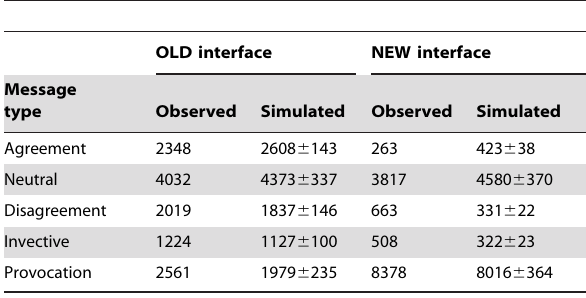
Table 6. Comparison of the observed and simulated characteristics of the comments posted by the